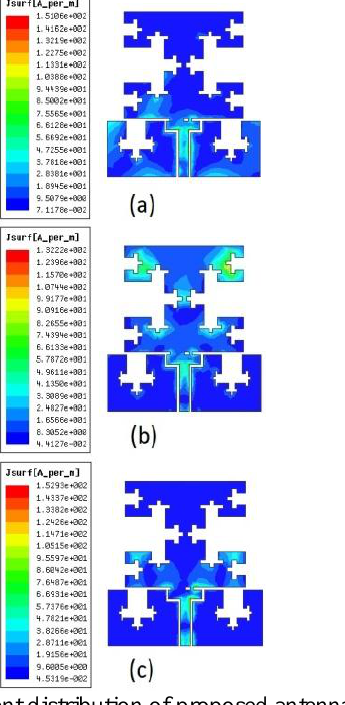
Figure 6: Current distribution of proposed antenna (a) at 2.6 GHz (b) at 4.4 GHz (c) at 8.7 GHz